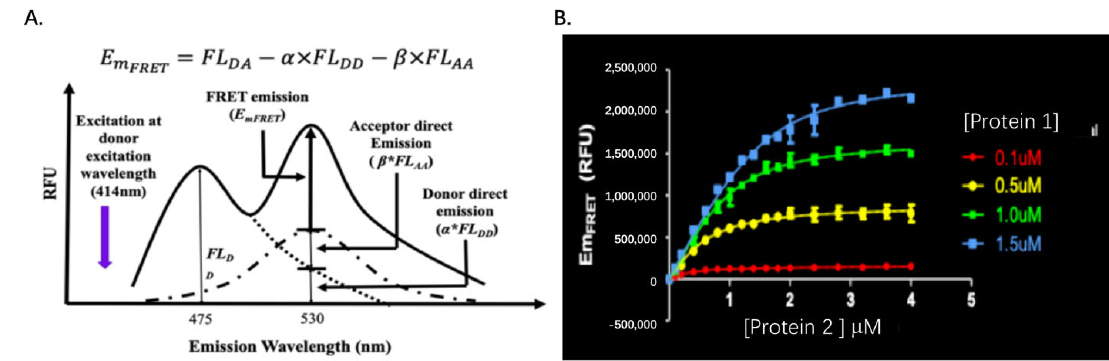
Figure 3. FRET acceptor emission signal for protein equilibrium constant K D determination: A. The FRET acceptor emission, as resulting from protein–protein interaction (E mFRET ), is extracted from the total fluorescence emission at the acceptor emission wavelength and is used to determine protein–protein bound complex; B. E mFRET signals at four concentrations of donor are determined using the method in A.